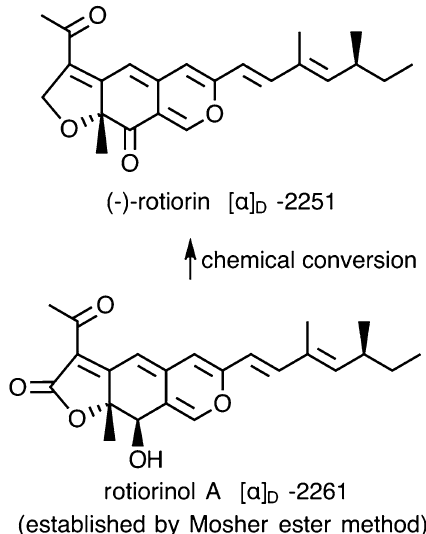
Fig. 3 Correlation between C-11 configuration and a large negative specific